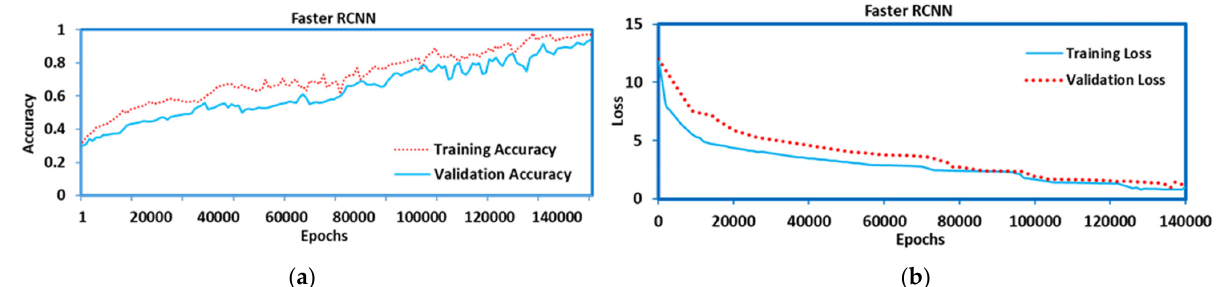
Figure 7. Training and validation process of modified Faster RCNN. ( a ) The curve of Accuracy. ( b ) The curve of Loss.